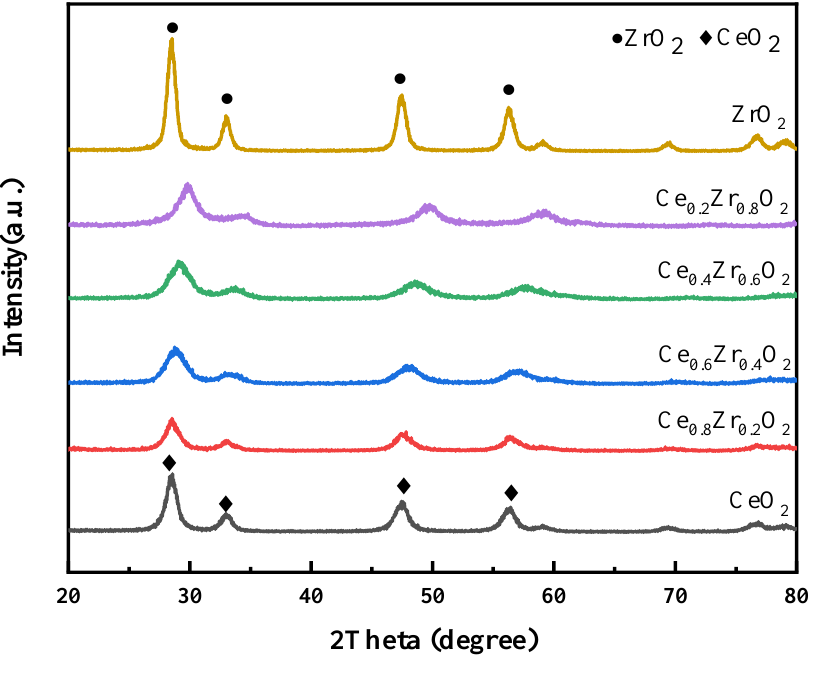
Figure 1. XRD pattern of Ce x Zr 1-x O 2.